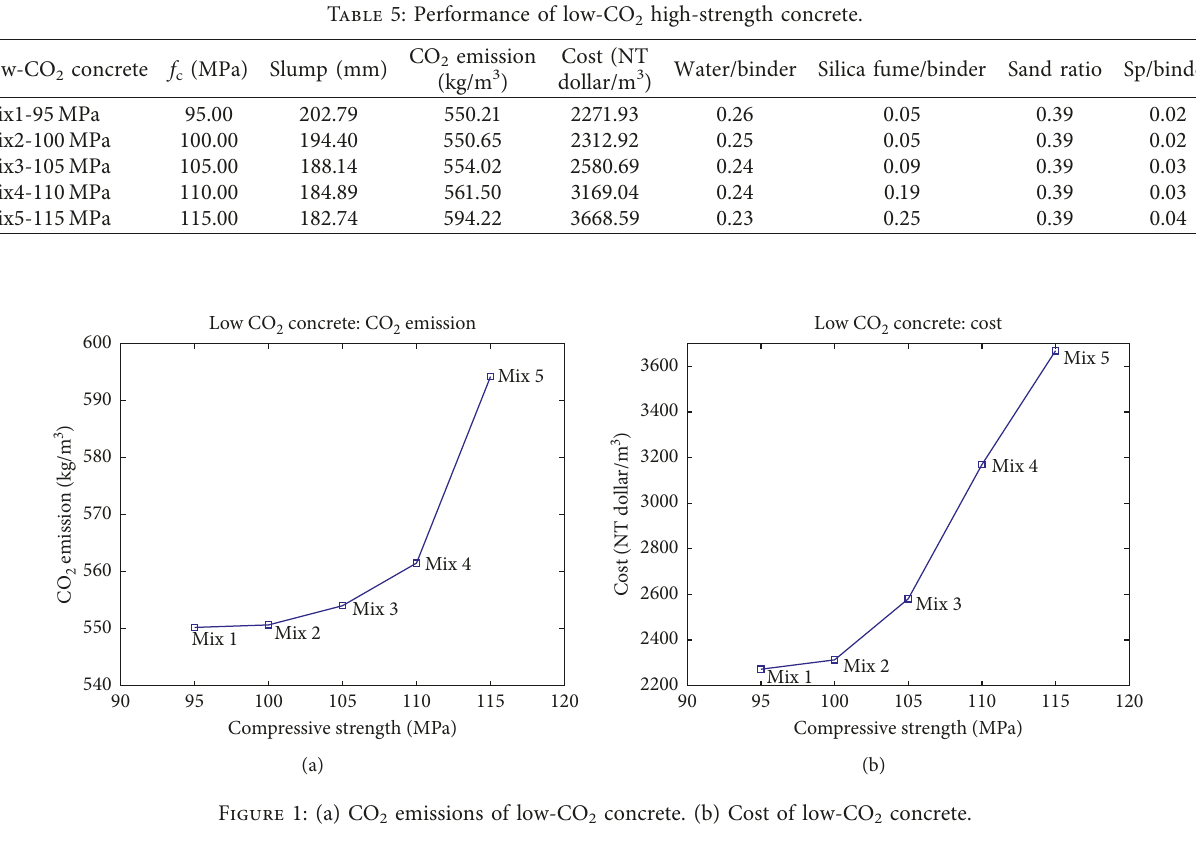
2 high-strength concrete.